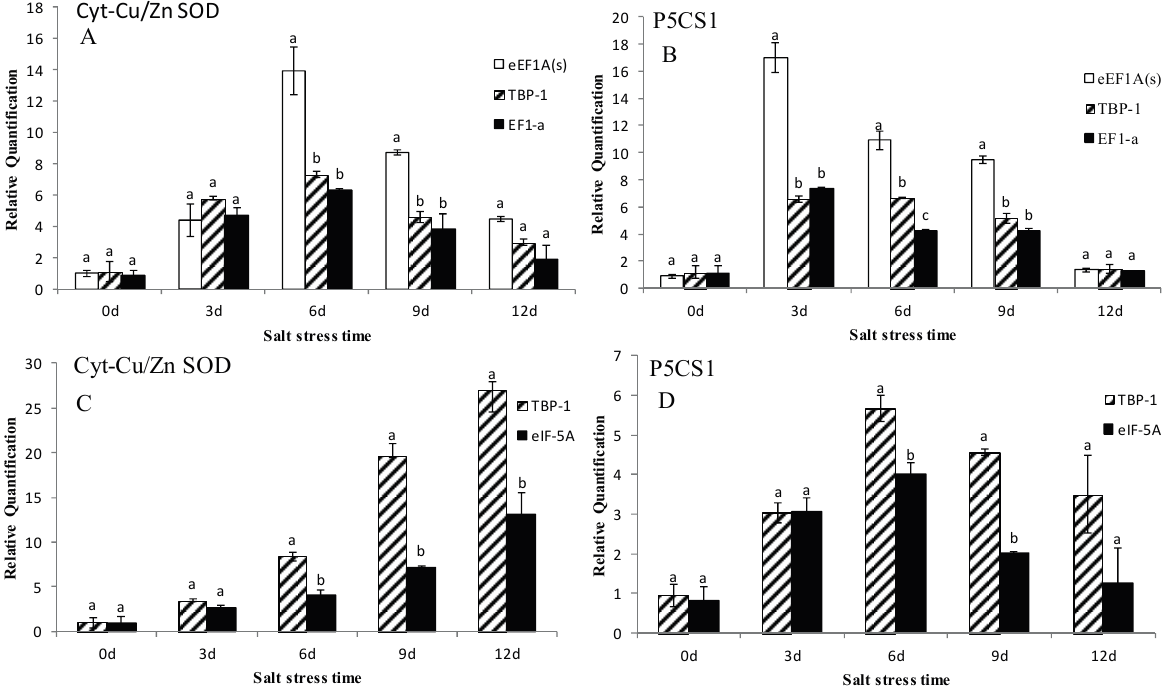
Figure 4. Expression levels of Cyt-Cu/Zn SOD and P5CS1 of annual ryegrass in leaves and roots under salt stress at different times (days 0, 3, 6, 9, 12). ( A , B ) represent expression levels of Cyt-Cu/Zn SOD and P5CS1 in leaves. ( C , D ) represent expression levels of Cyt-Cu/Zn SOD and P5CS1 in roots. Bars indicate standard error and the different letters above the bars represent significant difference ( p <